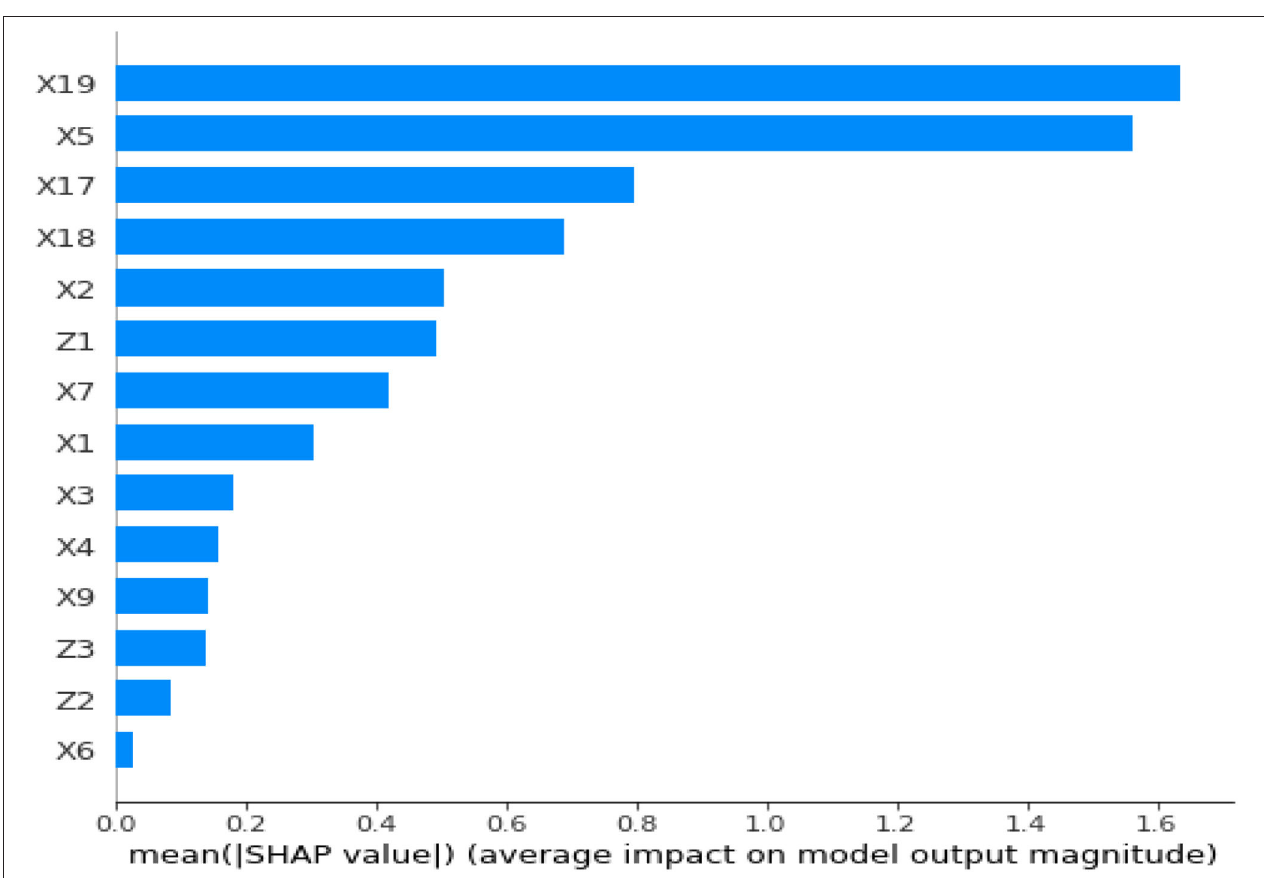
FIGURE 4 | Mean SHAP values of predictors in UHC in all the